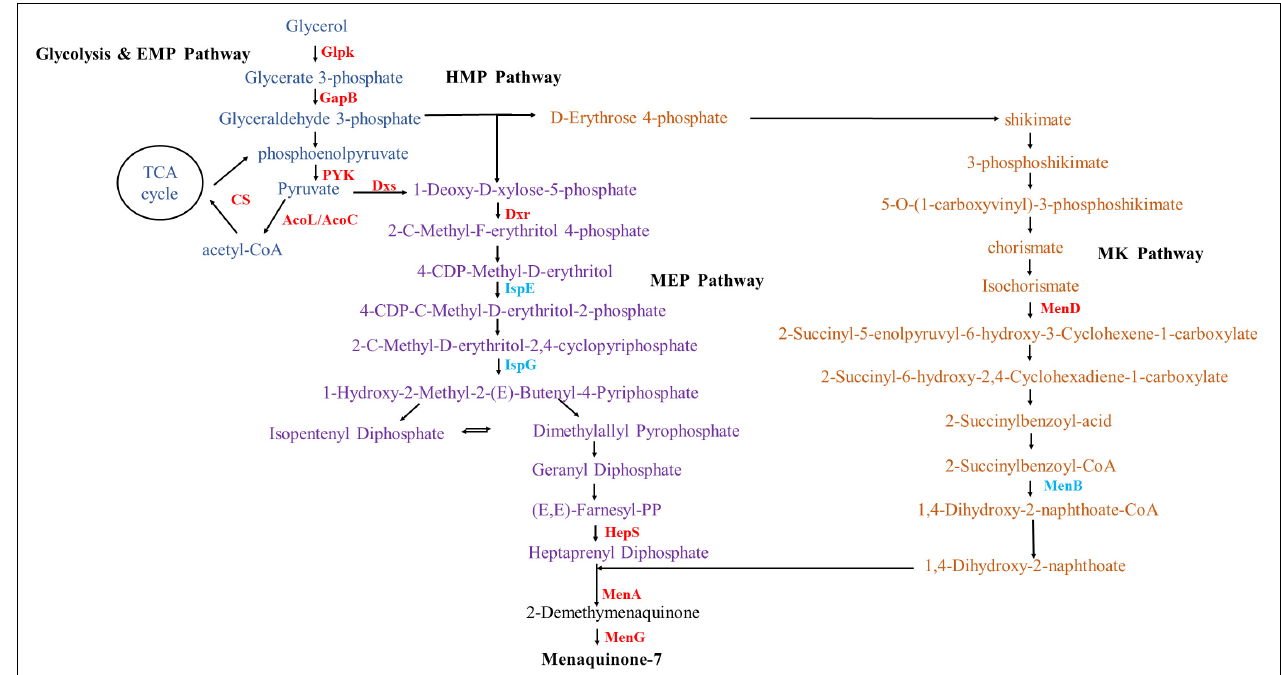
FIGURE 6 | Changes in transcript abundance of enzymes involved in menaquinone-7 metabolic pathway. Enzymes: GlpK, glycerol kinase; GapB, glyceraldehyde-3-phosphate dehydrogenase (NADP-dependent, gluconeogenesis); CS, citrate synthase; AcoL/AcoC, acetoin dehydrogenase E3/E2 component (dihydrolipoamide dehydrogenase); Dxs, 1-deoxyxylulose-5-phosphate synthase; Dxr, 1-deoxy-D-xylulose 5-phosphate reductoisomerase; IspE, 4-diphosphocytidyl-2-C-methyl-D-erythritol kinase; IspG, 4-hydroxy-3-methylbut-2-en-1-yl diphosphate synthase; IspA, farnesyl diphosphate synthase; HepS, heptaprenyl diphosphate synthase component I; MenD, 2-oxoglutarate decarboxylase and 2-succinyl-5-enolpyruvyl-6-hydroxy-3-cyclohexene-1-carboxylic-acid synthase; MenB, 1,4-dihydroxy-2-naphthoyl-CoA synthase; MenA, 1,4-dihydroxy-2-naphthoate octaprenyltransferase; MenG, demethylmenaquinone